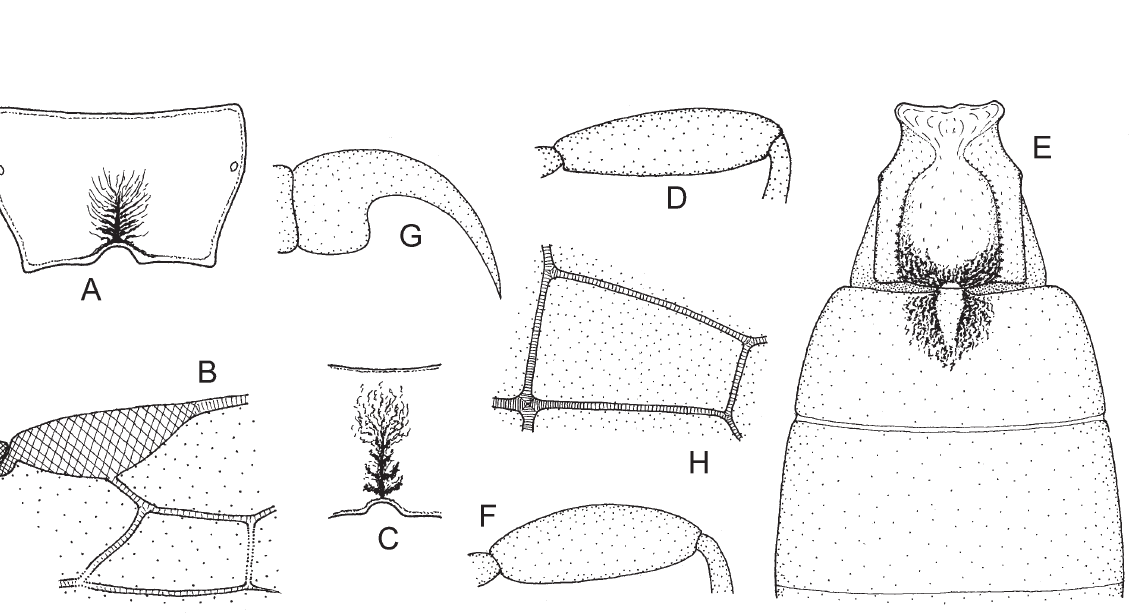
Fig. 15. — A-D . Bracon ( Lucobracon ) guttiger Wesmael, 1838 (A: ♀ lectotype, B-D: ♀ paralectotype). A . Propodeum. B . Middle part of forewing: pterostigma and second submarginal cell. C . Middle part of propodeum. D . Hind femur. — E-H . Bracon ( Lucobracon ) sphaerocephalus Szépligeti, 1901,